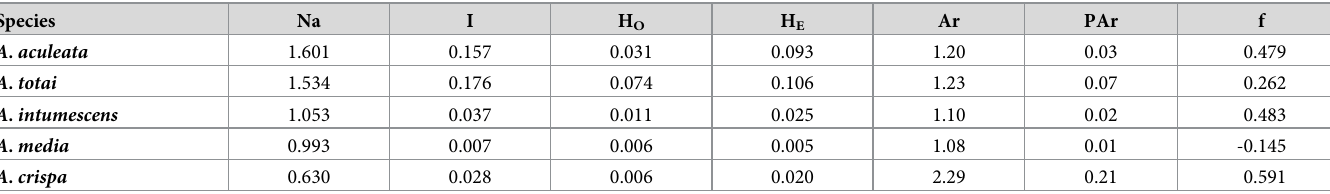
Table 2. Genetic diversity parameter estimates for Acrocomia species calculated from 3227 neutral loci SNPs.